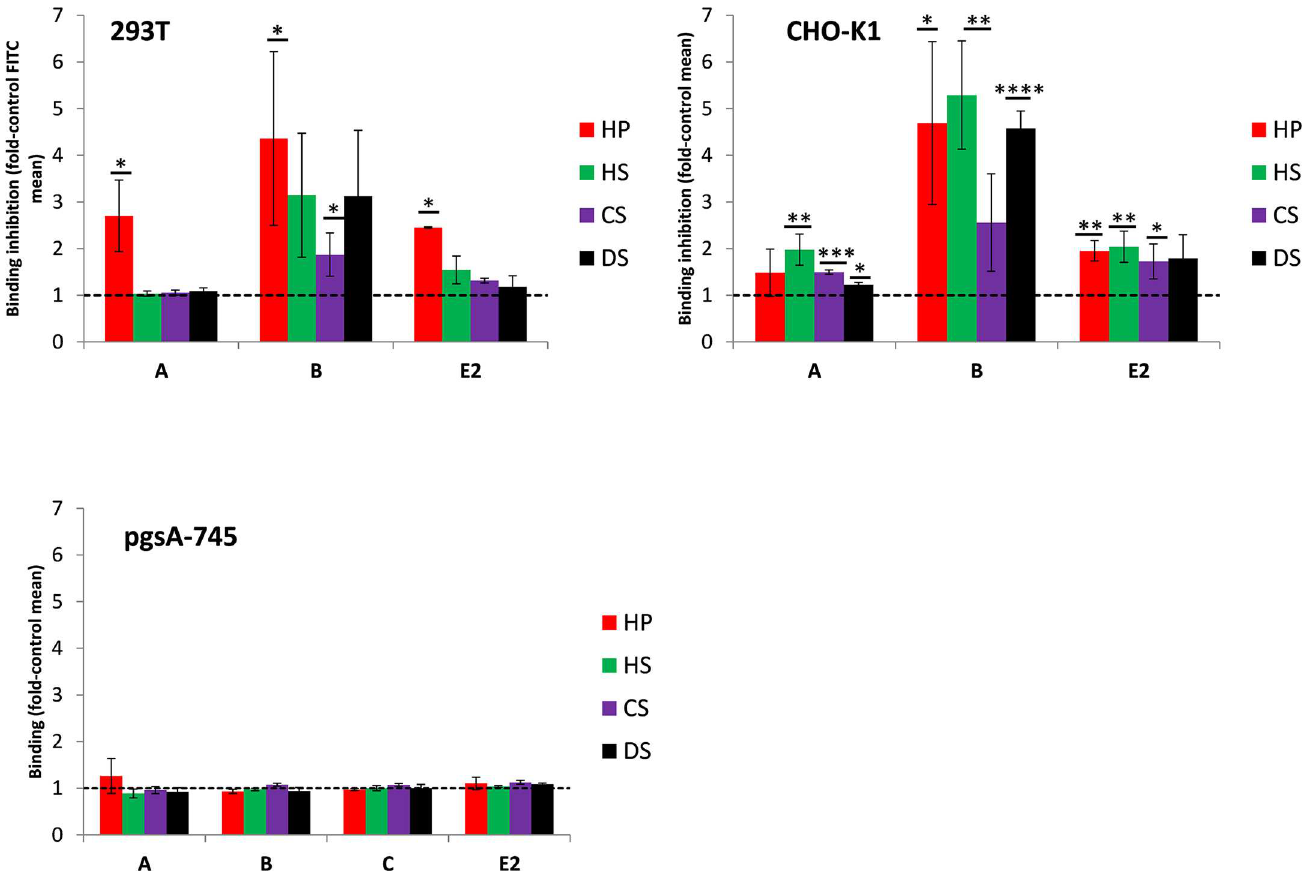
Fig 6. Binding of recombinant CHIKV E2 protein domains A, B, and C, and E2ex to 293T, CHO-K1, and pgsA-745 cells in the presenceof soluble glycosaminoglycans (GAGs). 10 μ g of the indicatedrecombinant proteins were incubatedwith the indicatedsolubleGAGs (500 μ g/ml) for 30 minutes at 4˚C. 293T (top), CHO-K1 (middle), and pgsA-745 (bottom) cells were then incubatedwith this mixture. Bindingwas measuredby flow cytometry using an anti-His-tag and an anti-mouse FITC conjugatedantibody. The results are shown as relativevalues to the control (incubation of cells with the respectiverecombinant protein alone). A value of one representsthe mean FITC value of the control and is labeledby the dashed line. Values abovethis line indicateinhibitionof binding.Data represent the averageof three independentexperiments. * and ** indicatesignificant differences to the GAG-free controls. n.s. means not significant. * (P (cid:20) 0.05), ** (P (cid:20) 0.01), *** (P (cid:20) 0.001) and **** (P (cid:20) 0.0001).